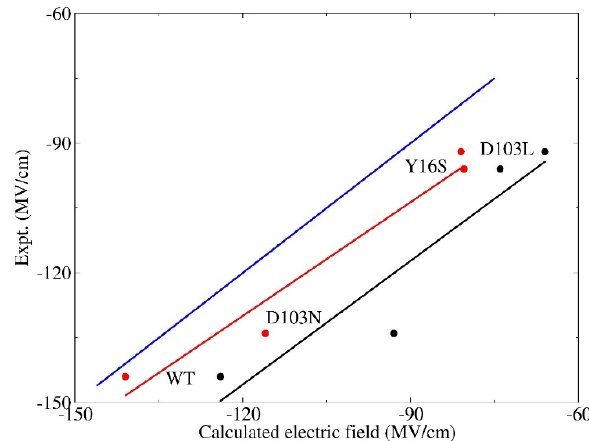
Figure 4. Correlation of the electric fields between the experimental results and theoretical calculations for wild-type and three variants (namely, D103N, Y16S, and D103L). The experimental values were obtained from Fried et al. [5]. The snapshots were taken from QM/MM MD simulations. The results calculated by EE-GMFCC are marked in red. The results calculated by the Amber ff99SB force filed are marked in black. The best-fit lines for these two methods are given in the same colors with R 2 = 0.96 (EE-GMFCC) and 0.91 (Amber ff99SB), respectively. The blue line represents the strict correlation curve.